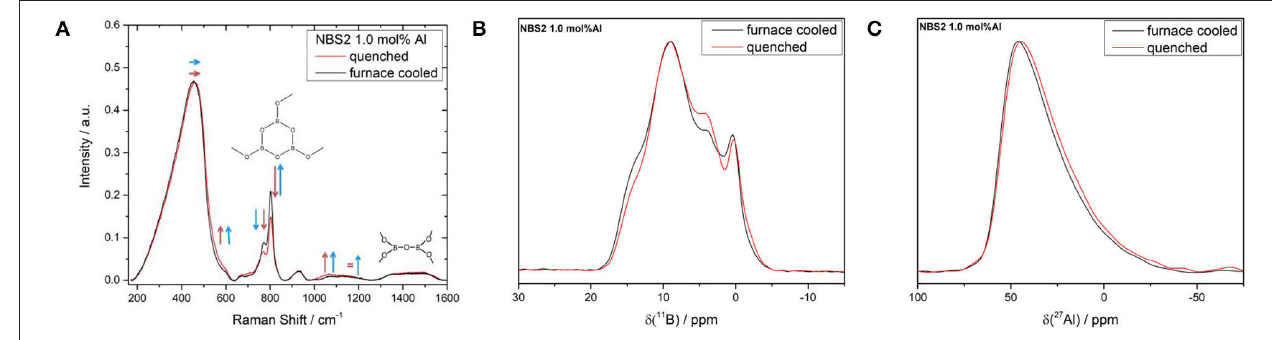
FIGURE 4 | (A) Thermal history effect on the glass structure obtained by Raman spectroscopy. Red arrows indicate changes by quenching while the blue arrows indicate changes upon Al 2 O 3 addition for comparison. (B) 11 B-MAS NMR and (C) 27 Al-MAS NMR spectrum of a furnace cooled and quenched sample.